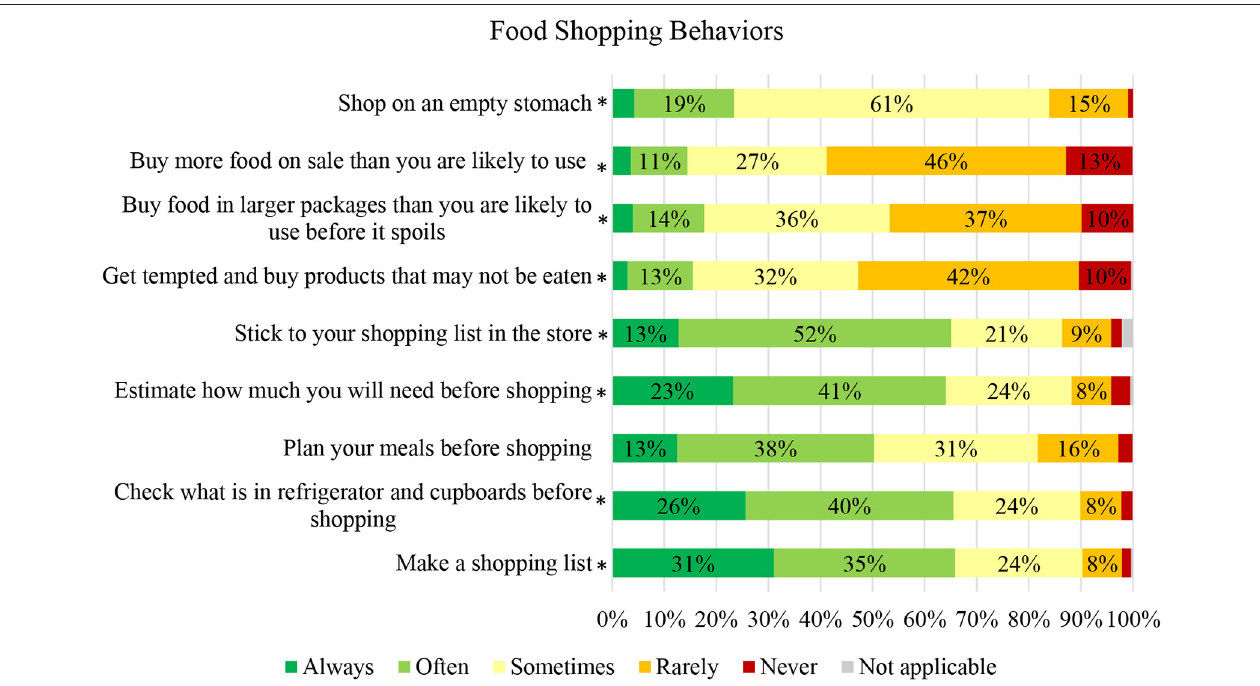
FIGURE 1 | Self-reporting of grocery shopping practices and behaviors (values < 5% not labeled in figure; *significant differences p < 0.05).